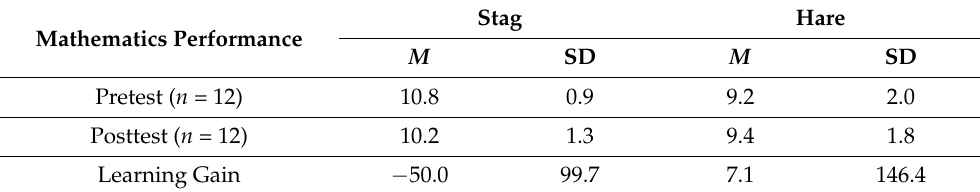
Table 2. The mathematics performance of stag and hare students in terms of pretest, posttest, and learning